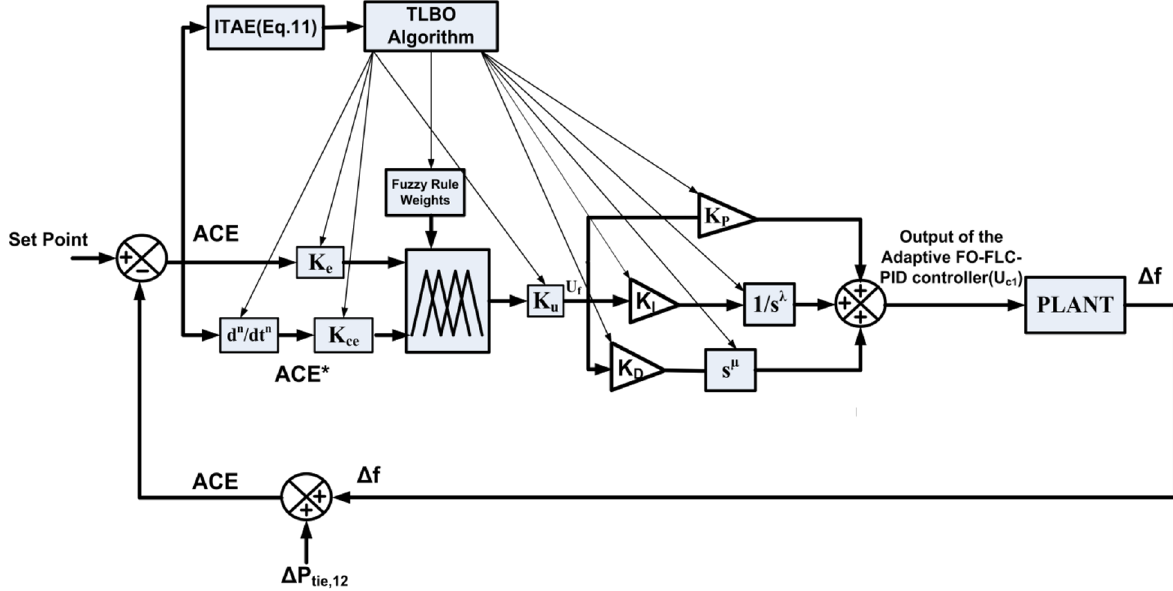
Fig. 7 Structure of proposed adaptive